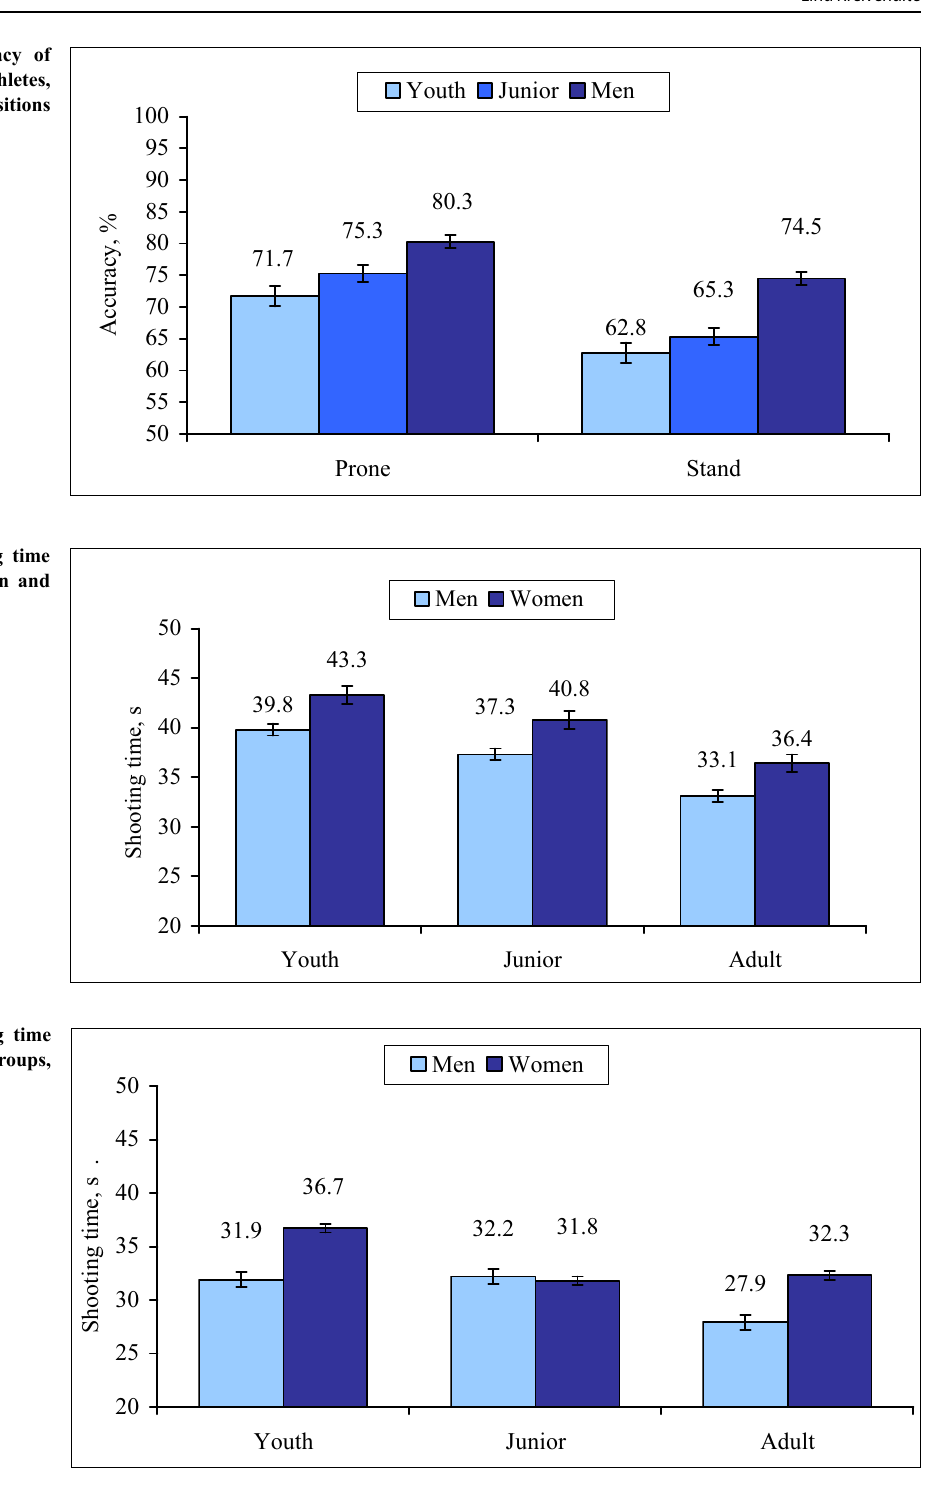
Figure 4 . Average shooting time of leaders in various age groups, men and women (X ± Sx)